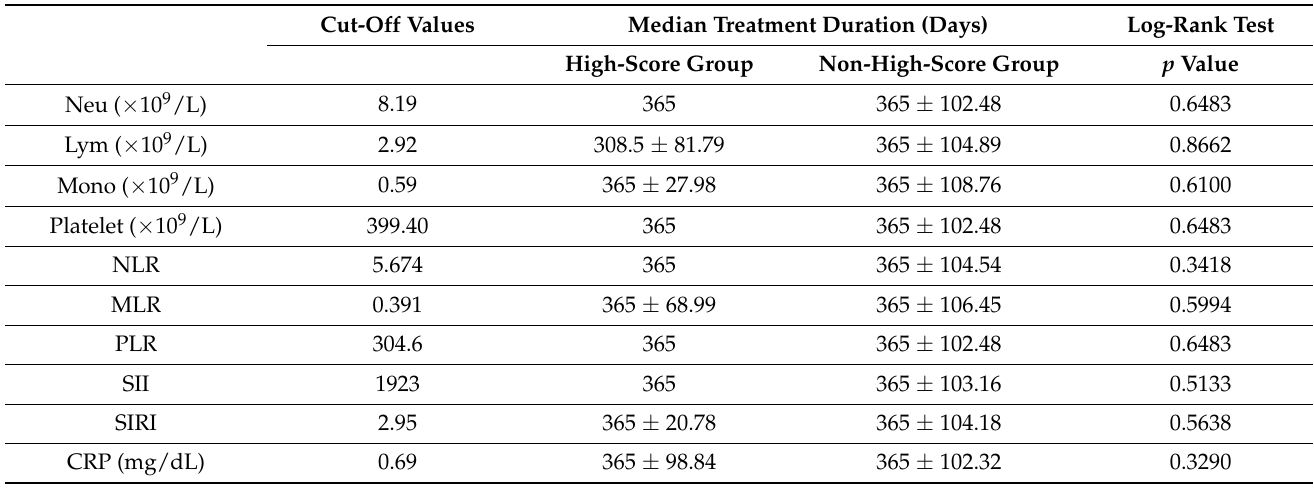
Table 6. Kaplan – Meier analyses for treatment continuation rates of patients who received treatment with biologics and by log-rank tests in patients with high and non-high scores for peripheral blood parameters and systemic inflammatory markers. Cut-Off Values Median Treatment Duration (Days) Log-Rank Test High-Score Group Non-High-Score Group